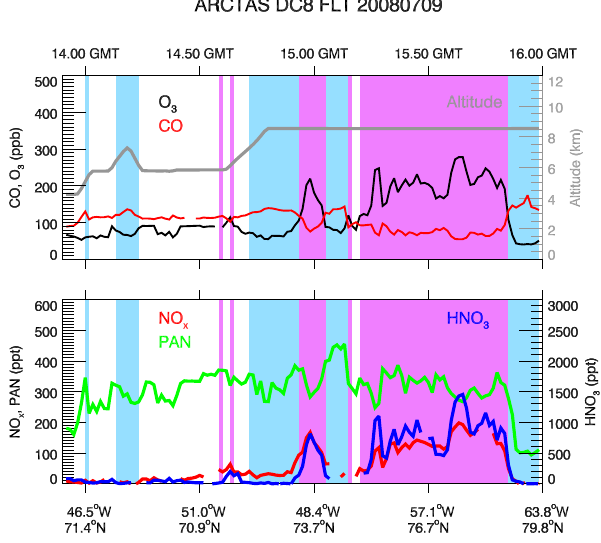
Fig. 7. Time series of aircraft altitude (top panel, gray line), observed CO, O 3 (top panel, red and black lines), NO x , PAN, HNO 3 (red, green and blue lines in middle panel) between 14:00– 16:00GMT for DC-8 flight on 9 July 2008. We highlight the identi- fied air masses in color shading: anthropogenic plumes (light blue) and stratosphere-troposphere mixed air (lilac).